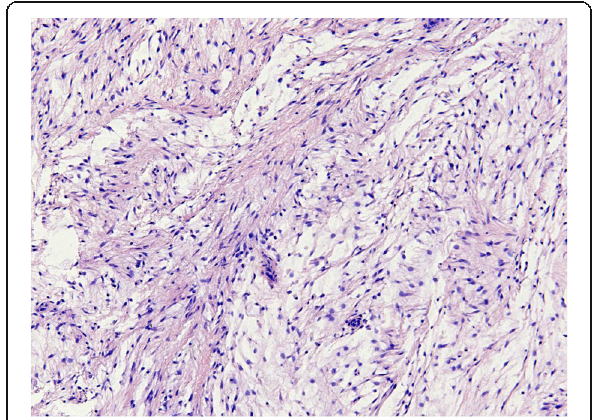
Fig. 1 Representative photomicrograph of heamatoxylin and eosine (H&E)-stained section of a cellular intramuscular myxoma showing its characteristic histological